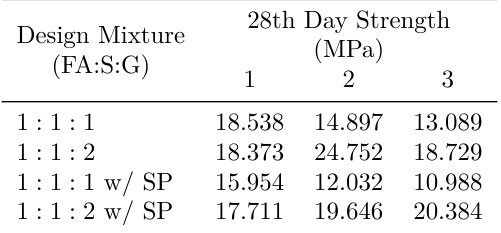
Table 4. Assessment of the Workability of the Geopolymer